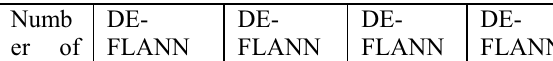
Table 4: Results Obtained From DE-FLANN for